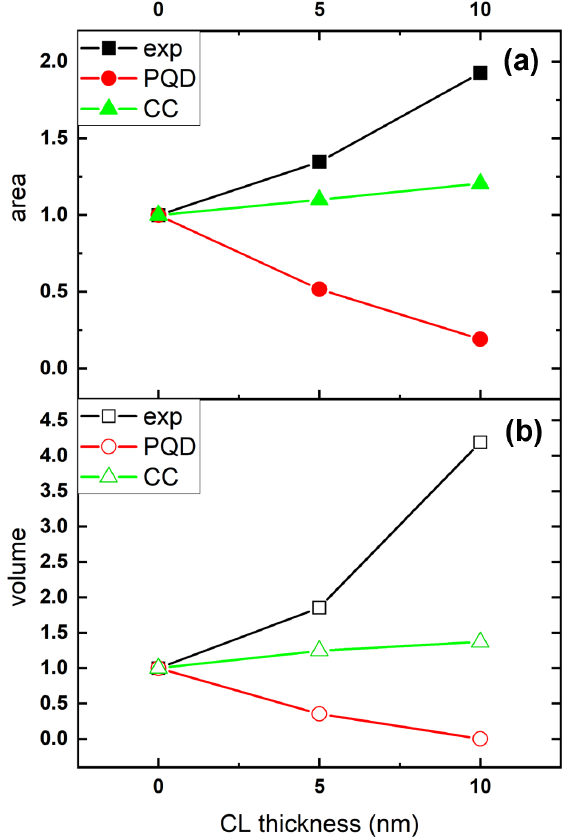
Figure 5. ( a ) Normalized average QD base area measured with AFM (black full squares), calculated with the PQD model (red full circles), and calculated with the CC model (green full triangles) as a function of the CL thickness; ( b ) normalized average QD volume measured with AFM (black hollow squares), calculated with the PQD model (red hollow circles), and calculated with the CC model (green hollow triangles) as a function of CL